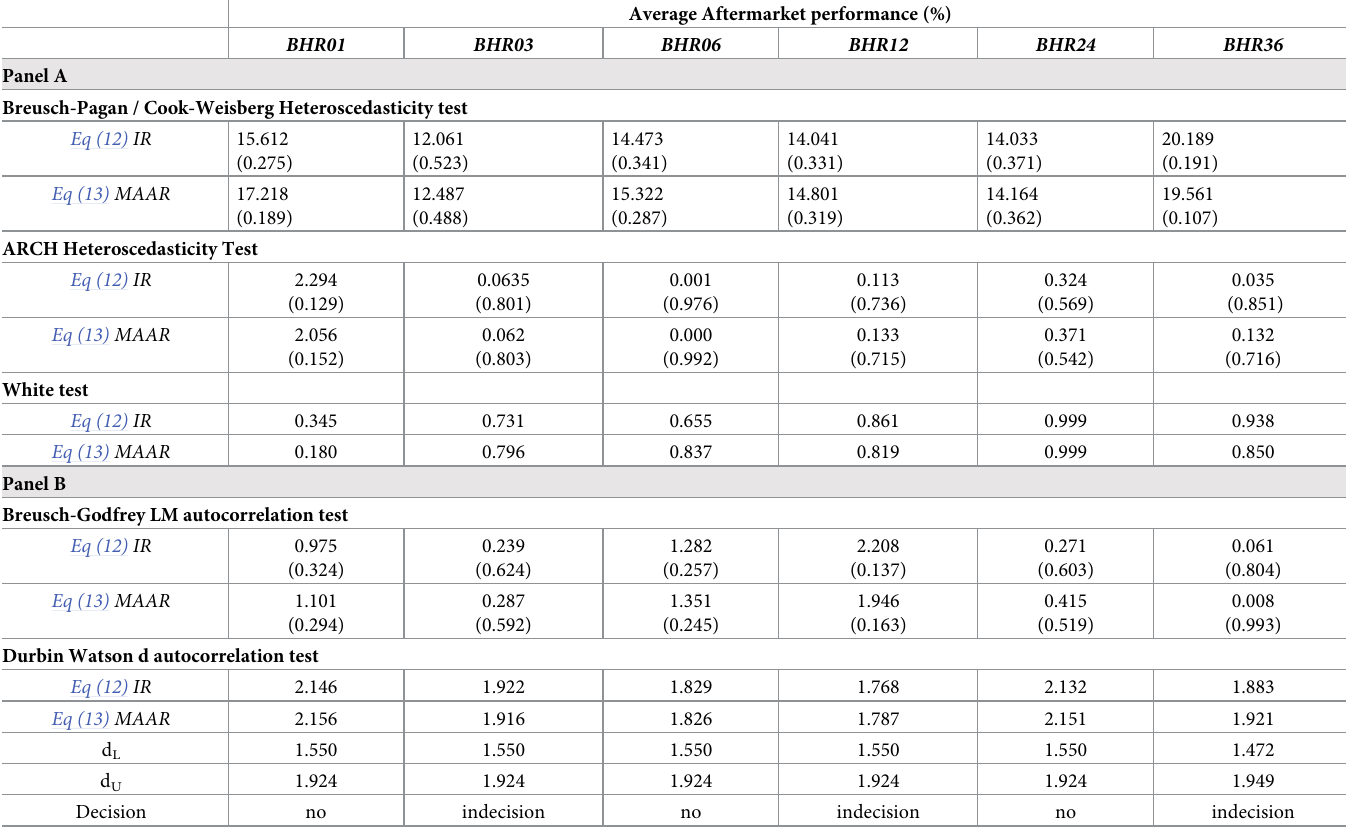
Table 11. Heteroscedasticity & autocorrelation tests.